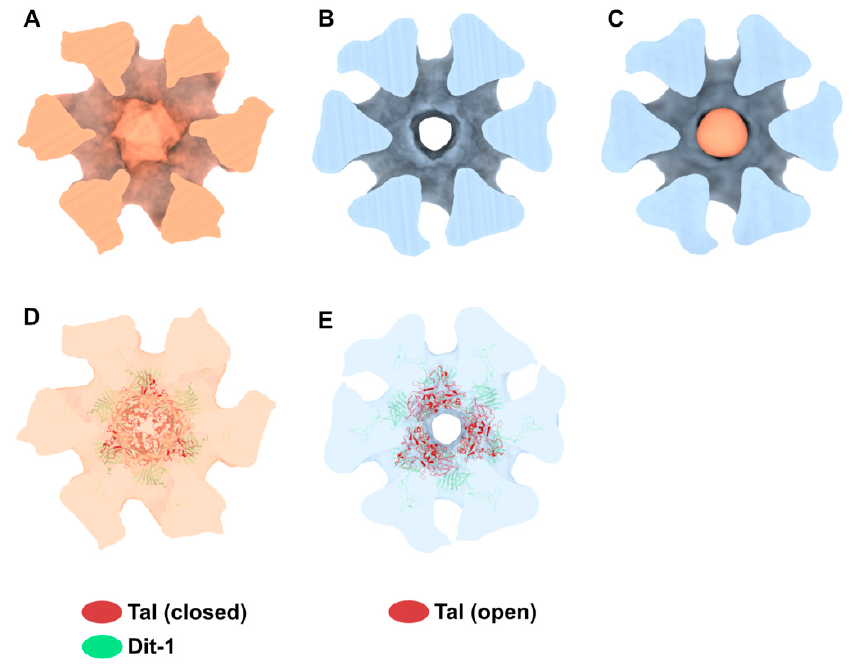
Figure 6. Activated baseplate in p2 virions with open and closed Tal. ( A , B ). 3D reconstructions of the baseplate in p2 virions, with Tal in closed (panel A, EMD-11225) and open (panel B, EMD-11224) conformations. Views along the tail axis towards the capsid. ( C ) The difference map calculated by subtracting the map shown in panel B (open Tal) to the map shown in panel A (closed Tal) is colored in light salmon. All three maps are contoured at 6 σ . ( D , E ) Ribbon representation of the Tal trimer in closed (PDB ID 2WZP) and open (PDB ID 2X53) conformation fitted into the nsEM maps. The hexameric Dit-1 is also shown. The RBPs and Dit-2 are not shown for clarity. Maps are contoured at 5 σ . The color code is indicated.